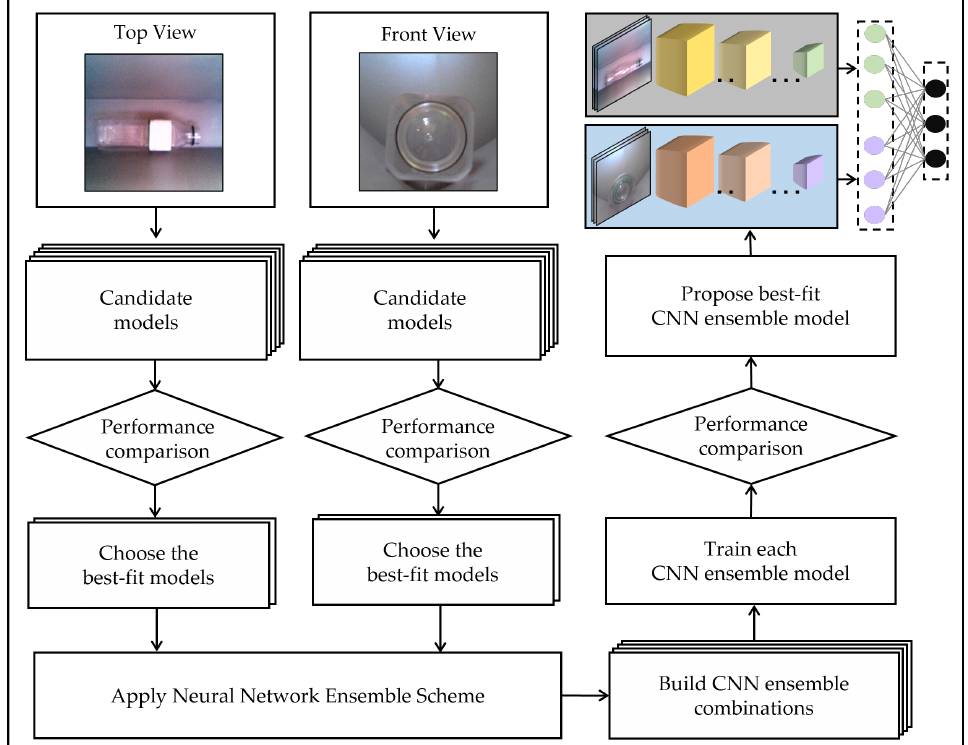
Figure 1. Workflow of choosing optimized classifiers and framework of the proposed CNN ensemble